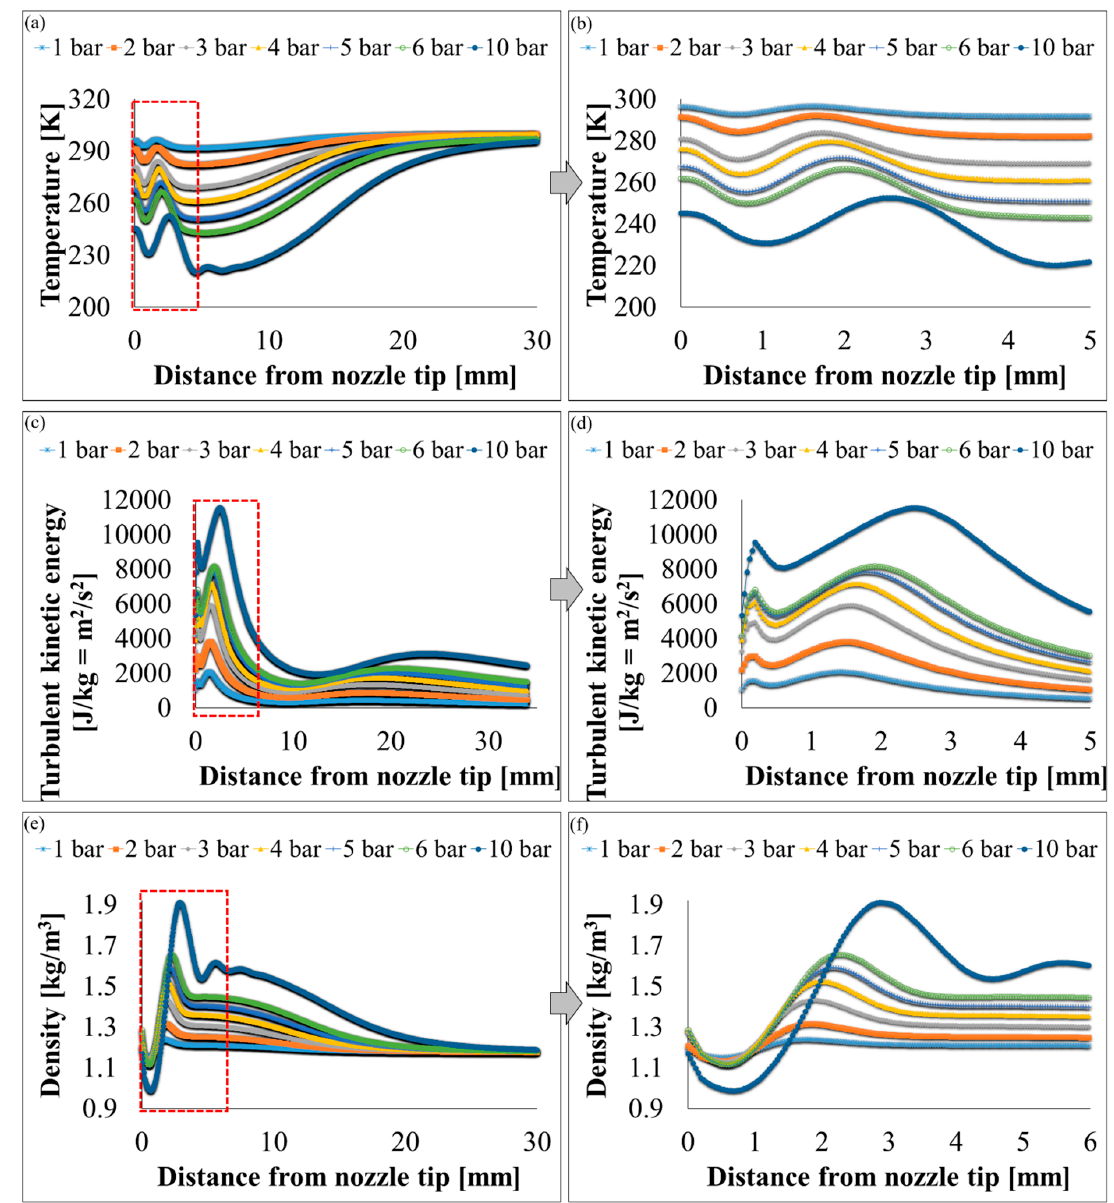
Figure 13. k- ε turbulence flow plots through SBS nozzle at different air pressures: ( a , b ) temperature (K), ( c , d ), turbulent kinetic energy (J/kg = m 2 /s 2 ), and ( e , f ) density [kg/m 3 ]. At 1 bar, v c increases quadratically to ~80 m/s at a distance of ~0.7 mm from the air outlet, then slows down due to reverse flow until hits zero, and then shoots up to ~120 m/s at a distance of ~7 mm